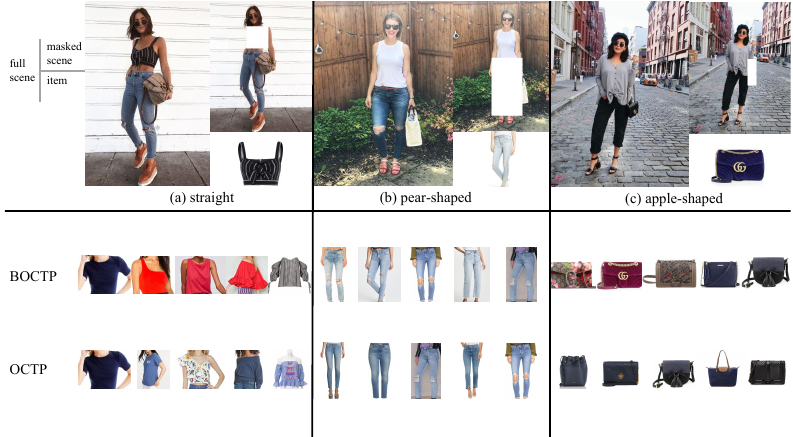
Figure 15. Visualizations of the top 5 recommendations of our proposed models OCTP and BOCTP on tops, pants and handbags.